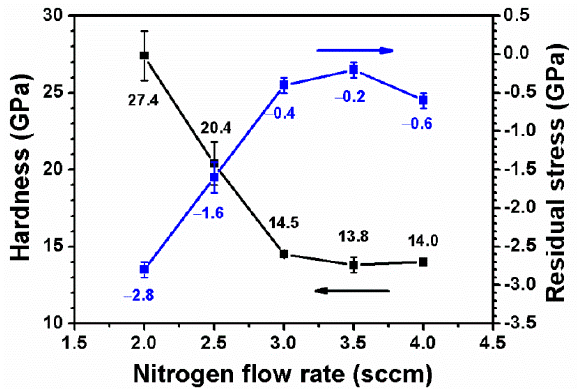
Figure 4. Nanoindentation hardness and residual stress values of Zr–Si–N films fabricated using various nitrogen flow rates.